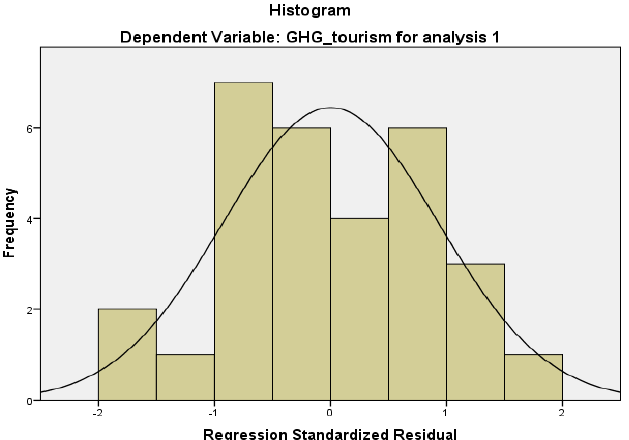
Figure 5. Histogram of model residuals. Source: Authors’ own contribution, based on data provided by EUROSTAT.